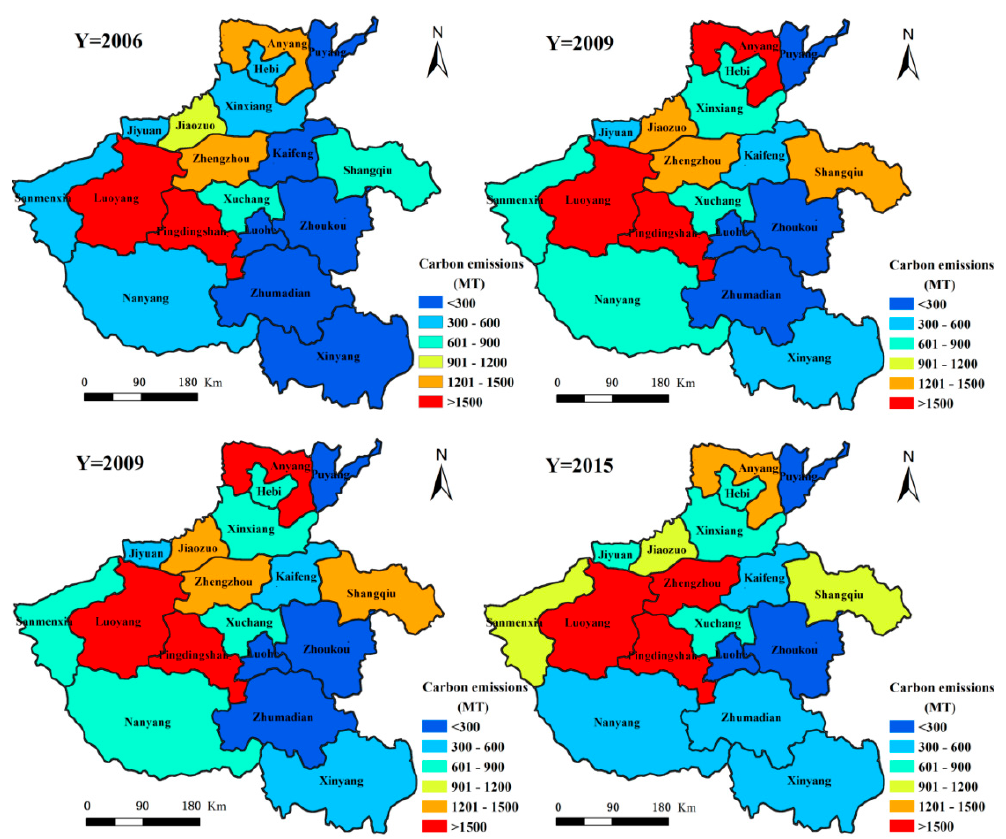
Figure 6. Spatial differences in carbon emissions from the tertiary sector in Henan Province during 2006-2015.